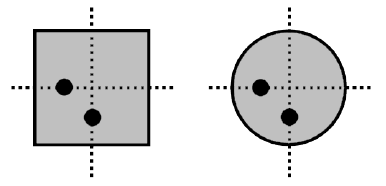
Figure 9. Dual-point fed antennas examples